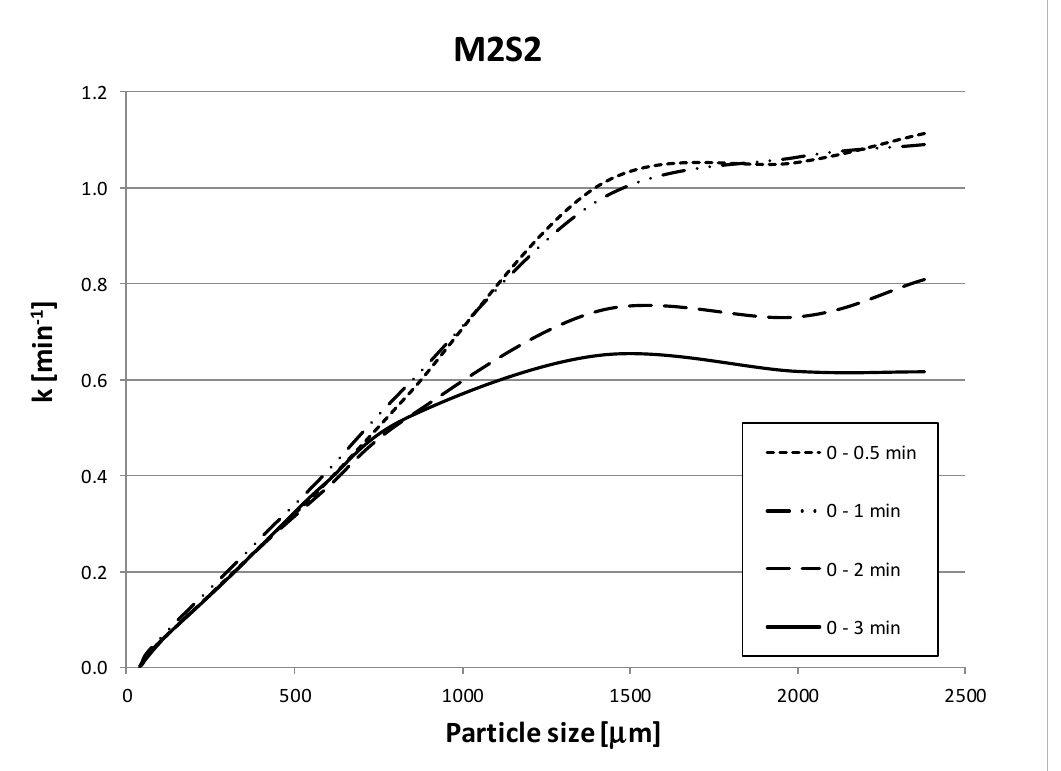
Figure 4. Graph showing the variation of k with particle size for different grinding times, in the case of M2S2 sample.